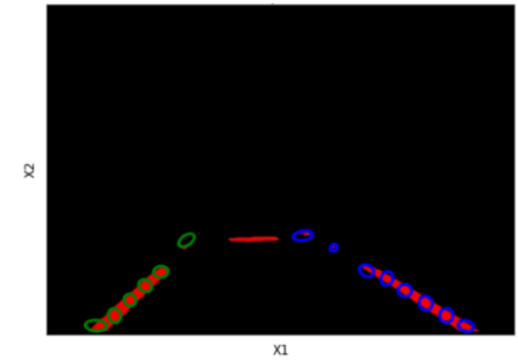
Figure 9. Ellipse filtering using RANSAC.